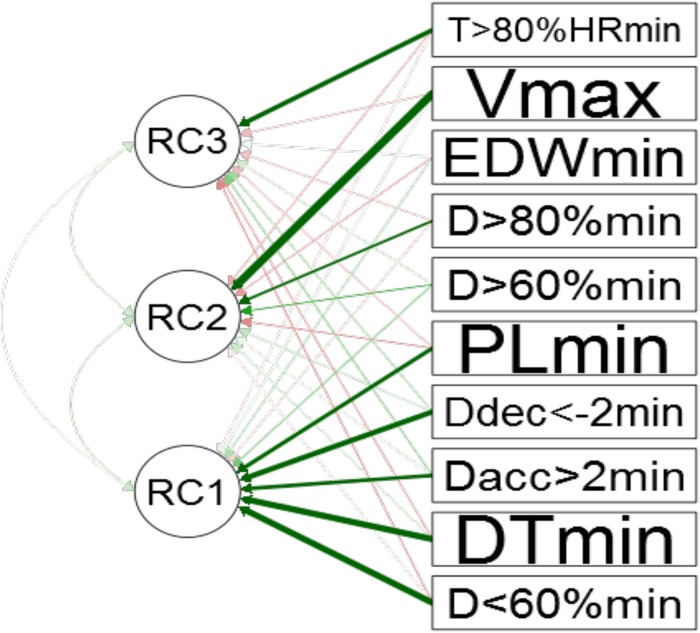
Results of the PCA, showing the rotated training load component loadings for each PC extracted (values above 0.7 are highlighted: in PC1, D < 60%min = 0.83, PLmin = 0.74, DTmin = 0.86, Dacc > 2min = 0.79, and Ddec < −2min = 0.84, in PC2, Vmax = 0.82 and D > 80%min = 0.72, and in PC3, T > 80%HRmin = 0.79).